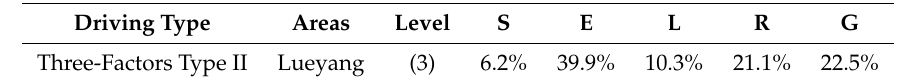
Table 8. Contribution rate of green development driving e ff ect of “Three Factors Type II” areas. Driving Type Areas